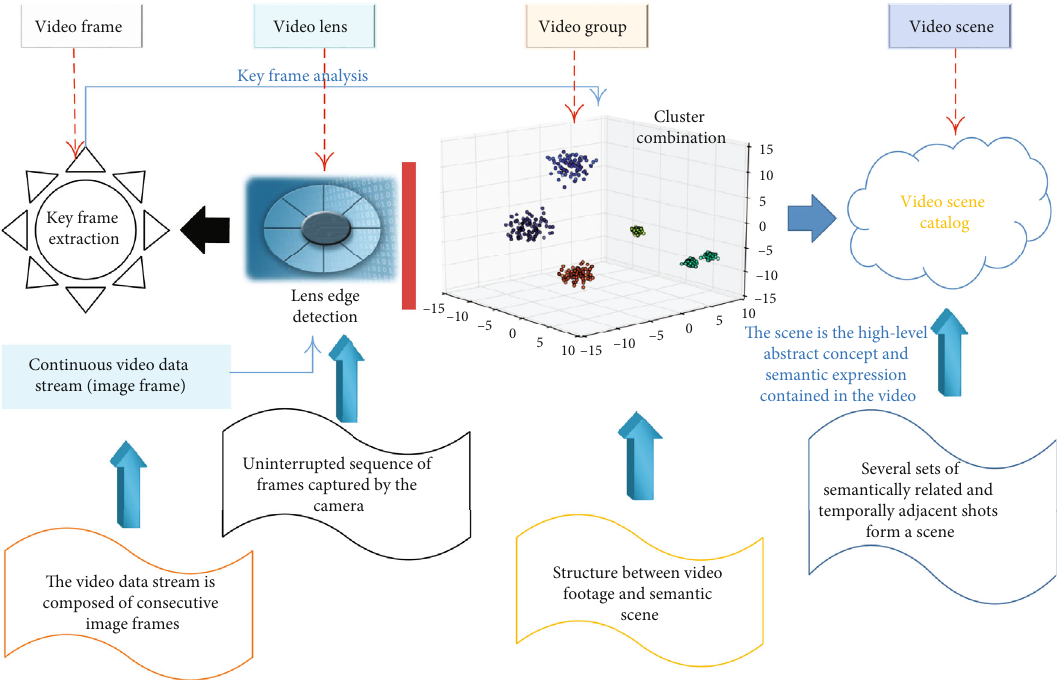
Figure 1: Schematic diagram of video data